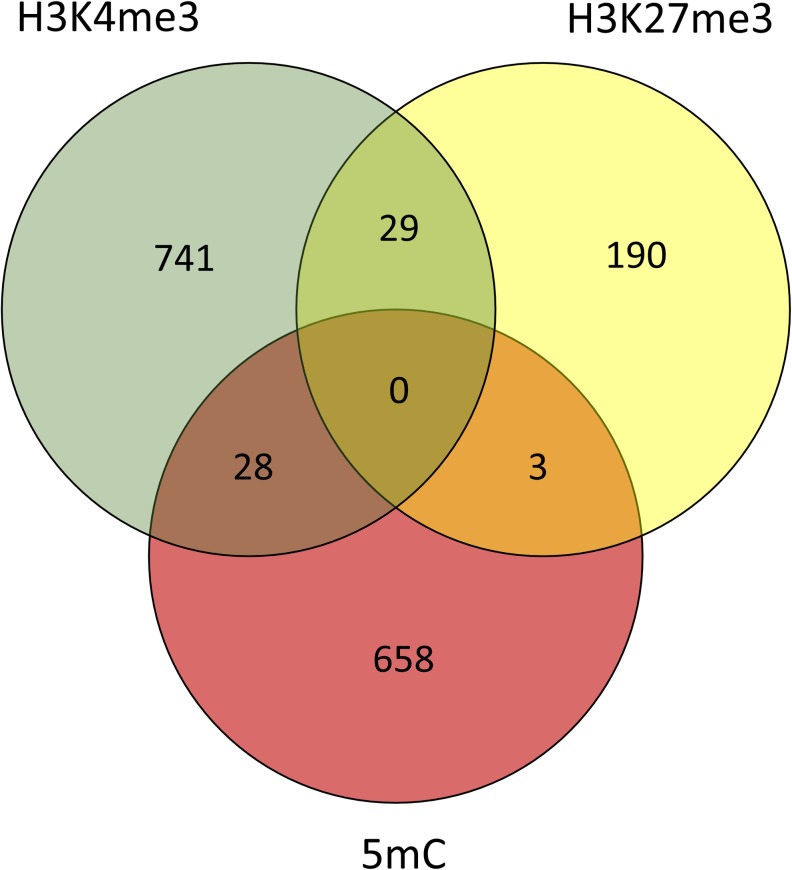
Combined gene list characterization, genes with either a DNA methylation, H3K4me3, or H3K27me3 change in their promoter.The number of genes proximal to each methylation change are shown in each circle. Genes proximal to multiple changes, regardless of the direction of those changes, are shown in overlapping regions.